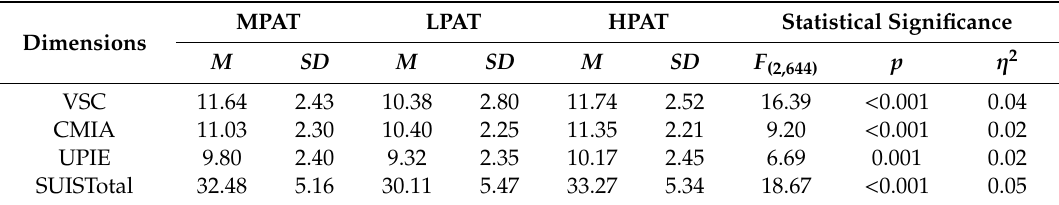
Table 1. Di ff erences between PAT profiles and visual mental imagery Table 1. Differences between PAT profiles and visual mental imagery dimension.